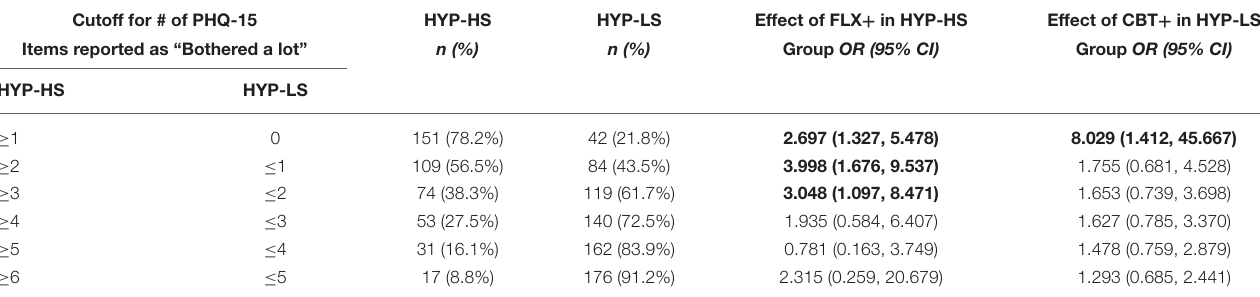
TABLE 4 | Sensitivity analysis: varying definition of HYP-HS and HYP-LS based on number of PHQ-15 items endorsed at the “Bothered a lot” level. Cutoff for # of